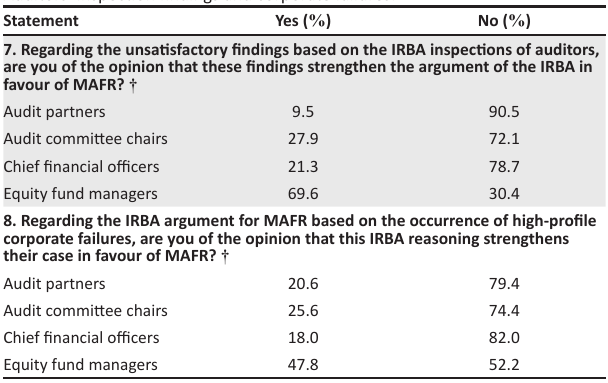
TABLE 3: Perceptions concerning the Independent Regulatory Board for Auditors’ inspection findings and corporate failures. Statement Yes ( % ) No ( %